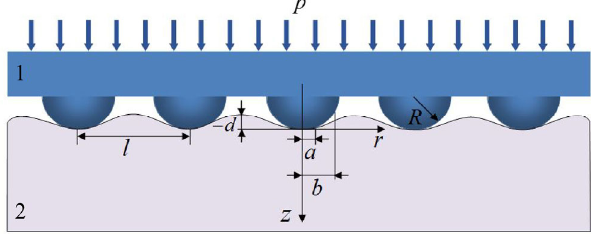
Fig. 1 Contact scheme between a rigid rough surface and an elastic half-space in the presence of